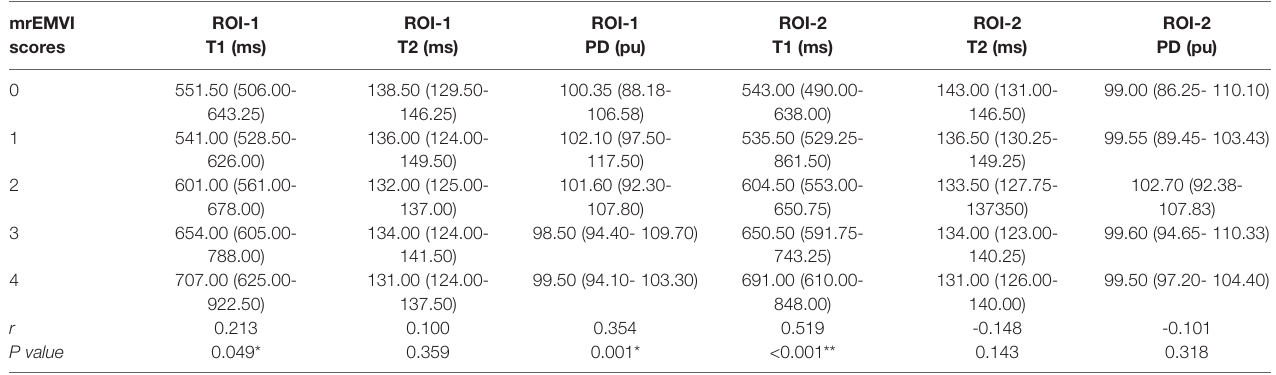
TABLE 5 | Quantitative relaxation maps for evaluating mrEMVI of Rectal cancer. mrEMVI